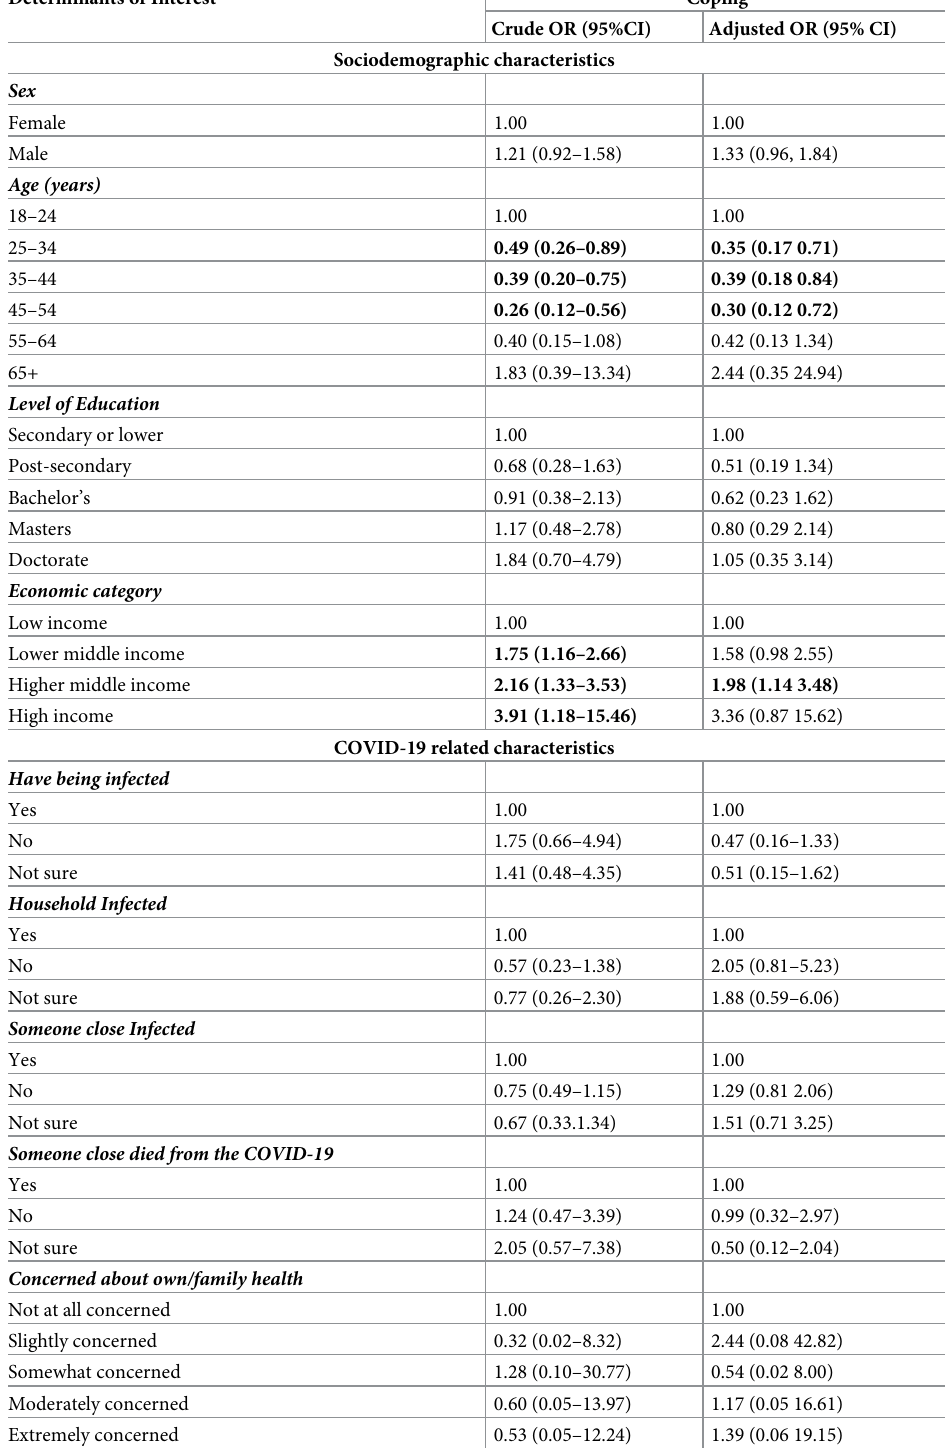
Table 7. Association of socio-demographic, COVID- 19 related characteristics, and engagement in activities with coping (n =